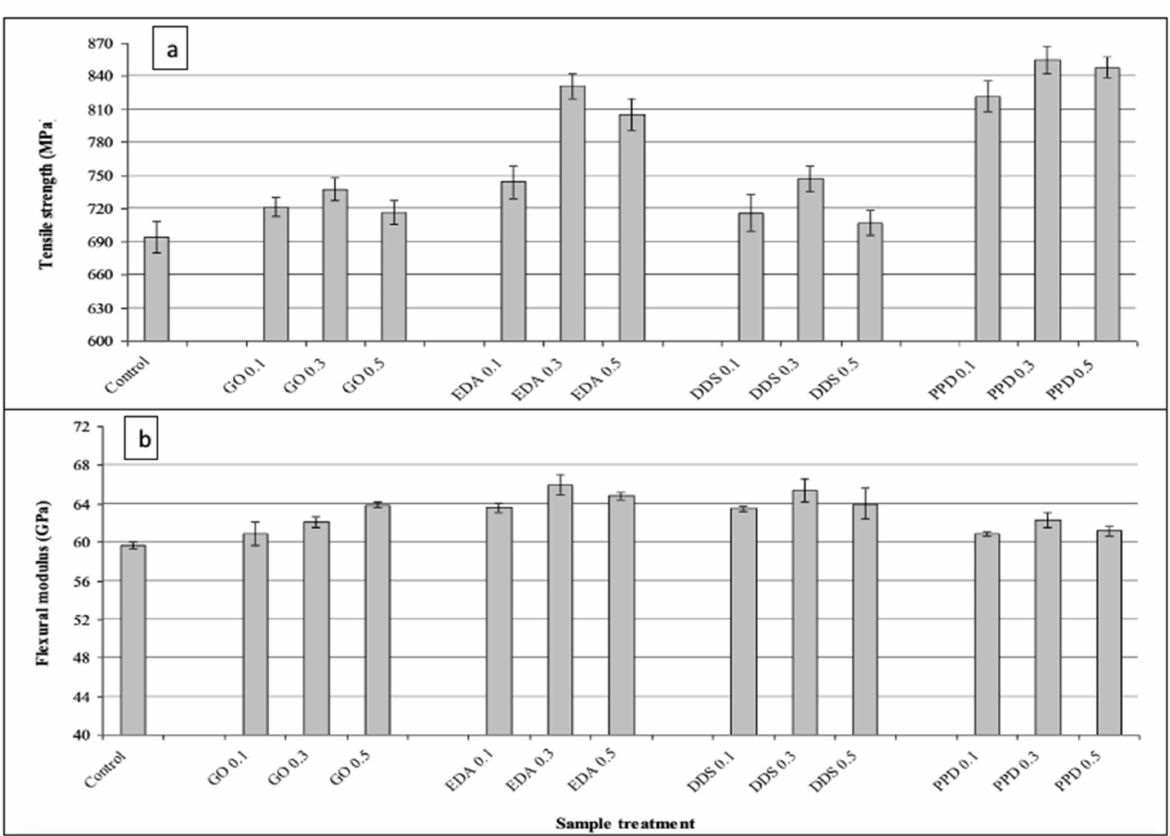
Figure 6. ( a ) Tensile strength; ( b ) flexural strength for different-solvents-treated GO/epoxy/CF compos- ites [60]. Obtained with permission from Polymer Testing; published by Elsevier,